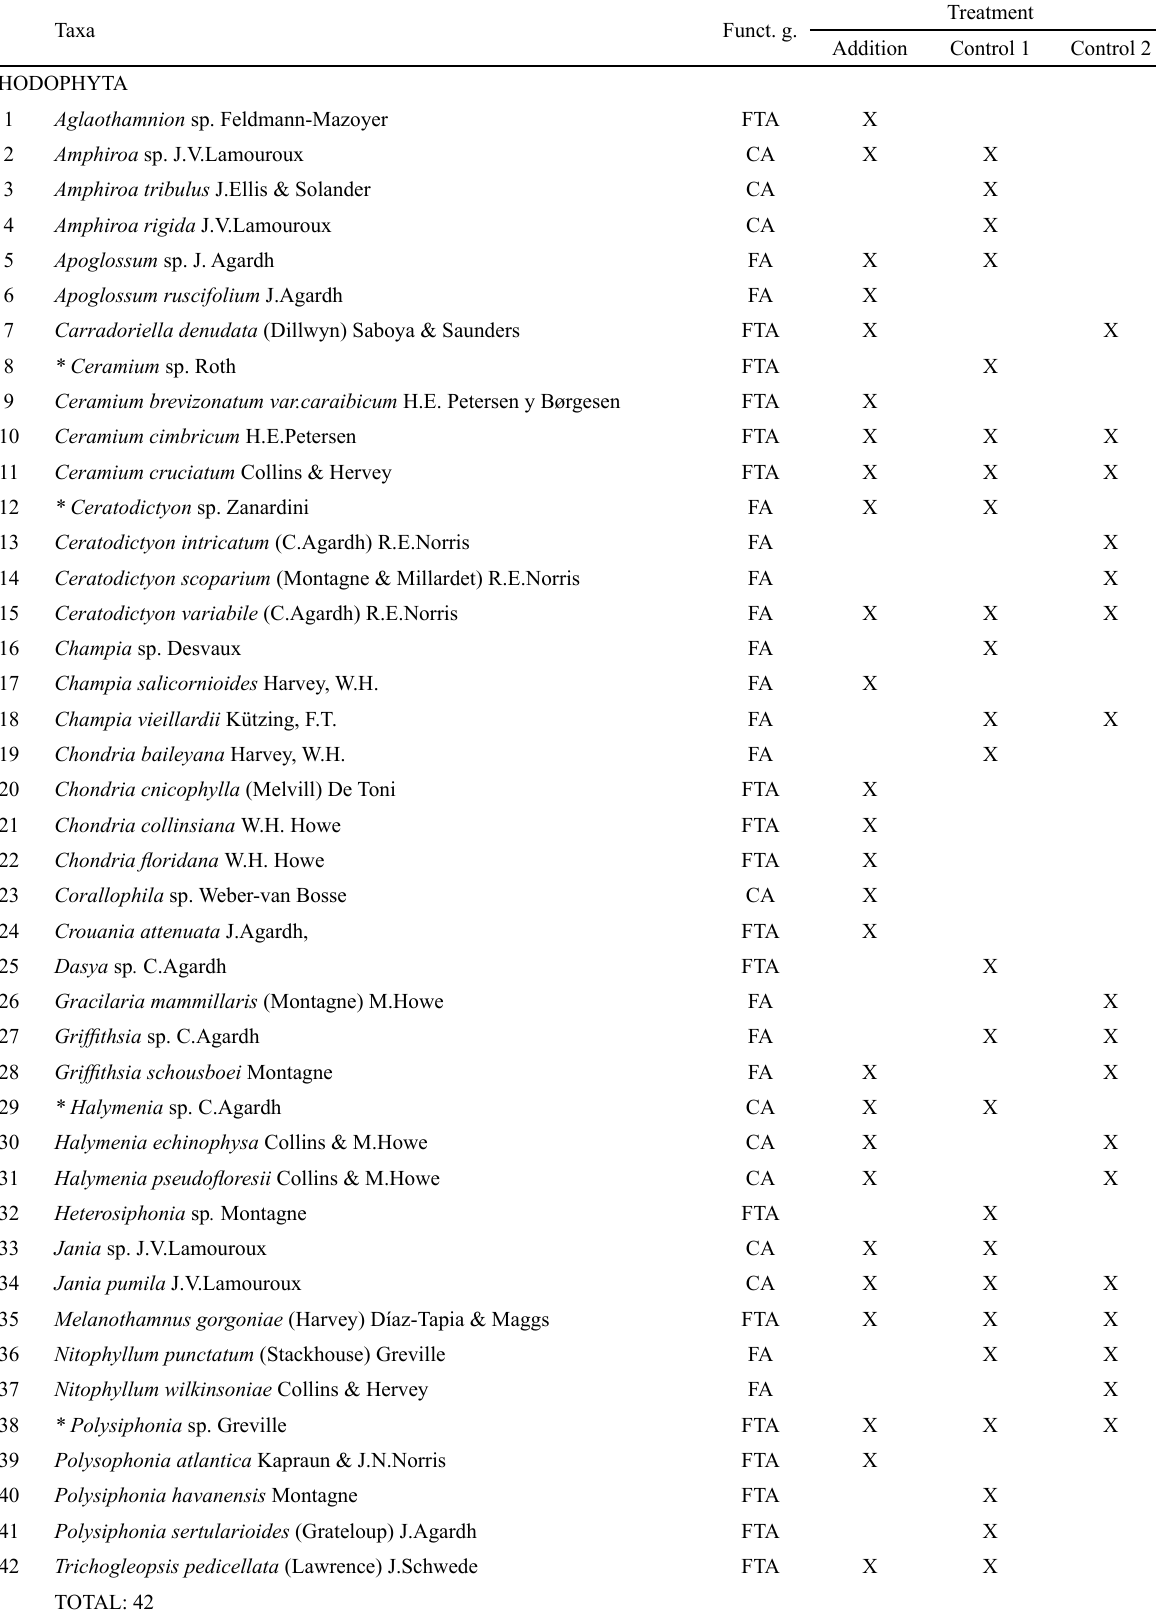
Table 1. – List of species identified in this study on sediment addition plates and natural condition plates (controls 1 and 2). The species indicated with * refer to the most abundant in each group represented in the experiment. FTA, filamentous turf algae; CA, coralline algae; FA, fleshy algae. Taxa Funct. g.